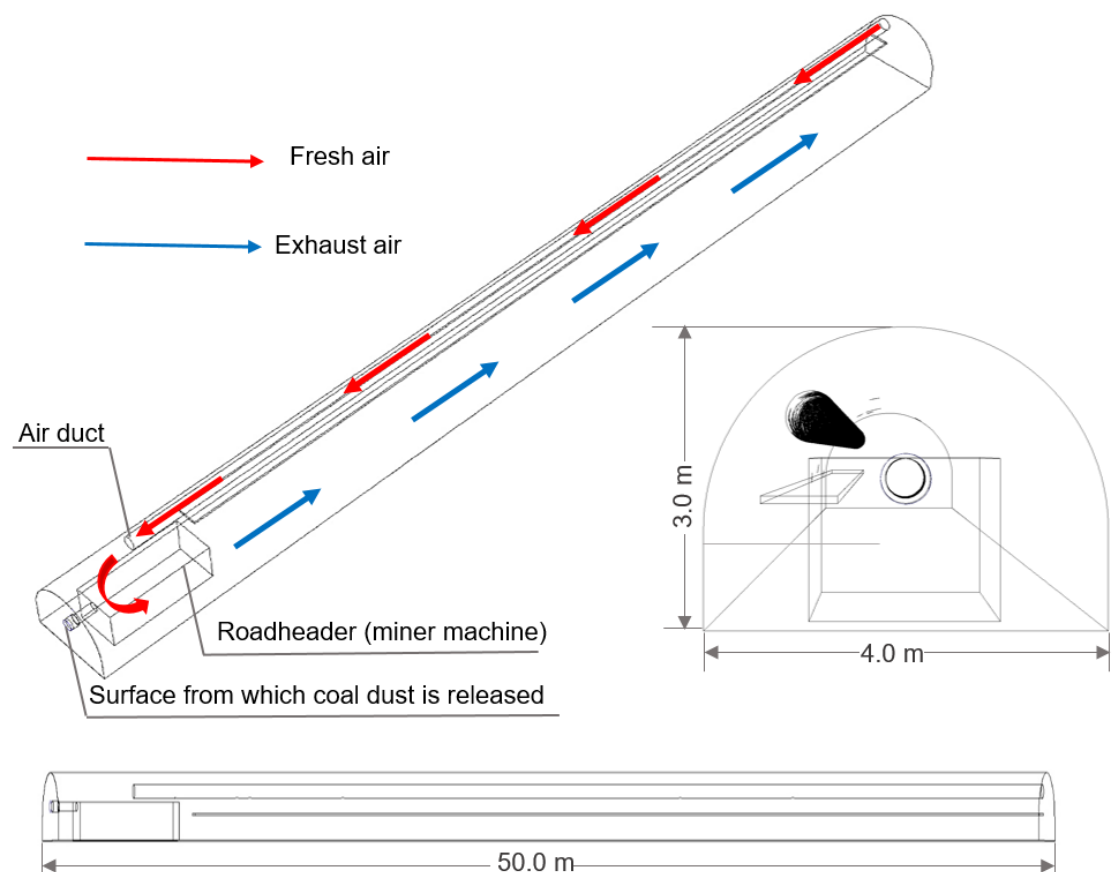
Figure 2. Geometric model of the studied dog heading with marked air flow directions.